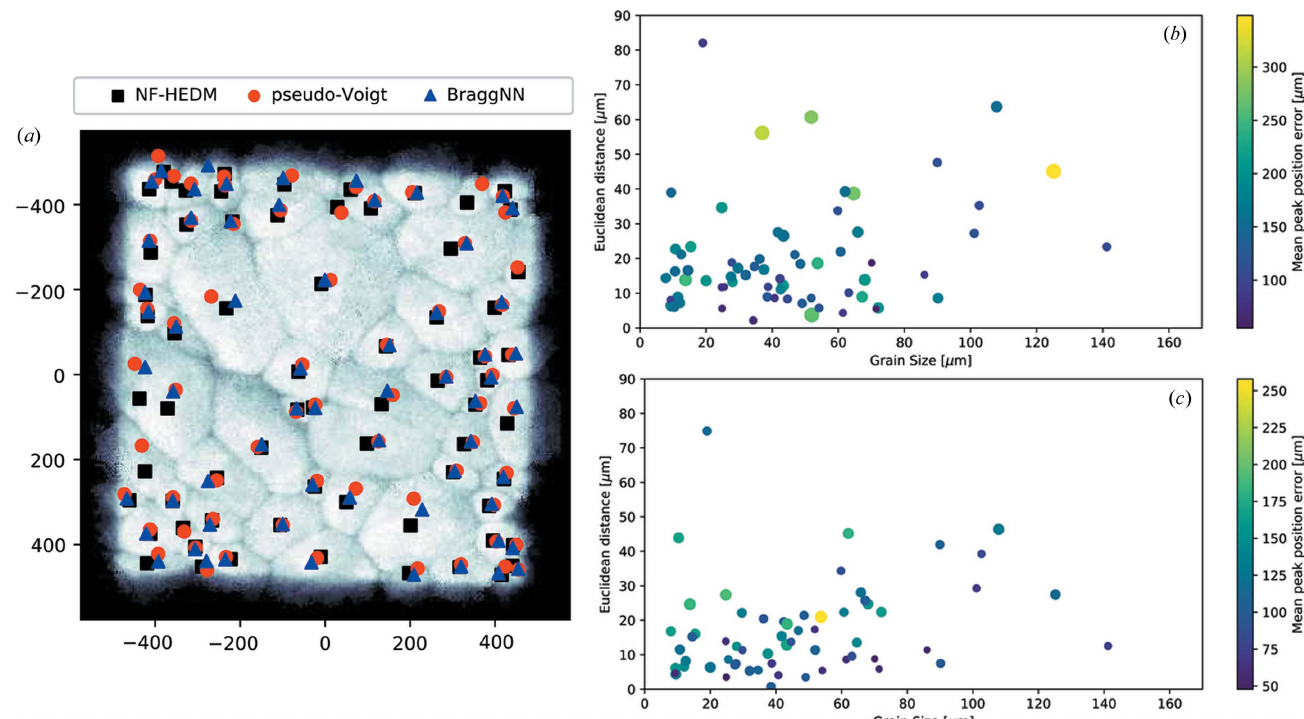
Figure 6 Comparison of BraggNN , pseudo-Voigt FF-HEDM and NF-HEDM. ( a ) Grain positions from NF-HEDM (black squares), pseudo-Voigt FF-HEDM (red circles) and BraggNN FF-HEDM (blue triangles) overlaid on the NF-HEDM confidence map. ( b )–( c ) Difference in the position of grains between pseudo-Voigt FF-HEDM ( b ), BraggNN and ( c ) NF-HEDM as a function of grain size. Color of markers in ( b )–( c ) represent the mean difference in position of expected and observed diffraction peaks. Size of the markers in ( b )–( c ) represent the mean internal angle (see